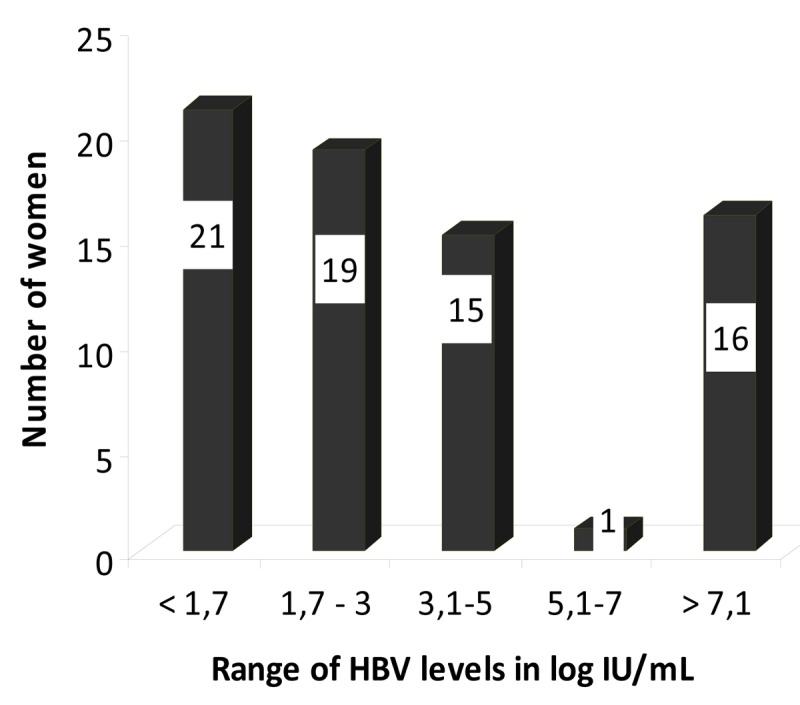
HBV DNA quantification.Serum HBV DNA levels were quantified in 72 consecutive samples with the Abbott Real Time HBV PCR (threshold at 1.7 log IU/mL). HBV target was not detected in 21 patients; viral load was detected in 51 patients, 16 of whom had a viral load greater than 7 log IU/mL.